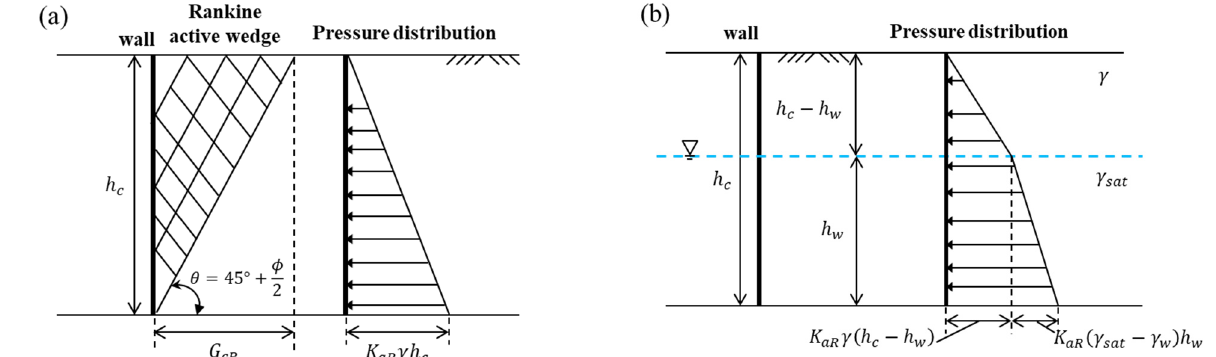
Figure 2. Rankine’s active earth pressure distributions: ( a ) Rankine’s active wedge; ( b ) effect of the still water level on lateral earth pressure.